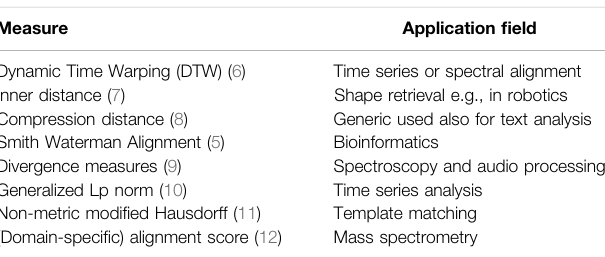
TABLE 1 | List of commonly used non-metric proximity measures in various domains.